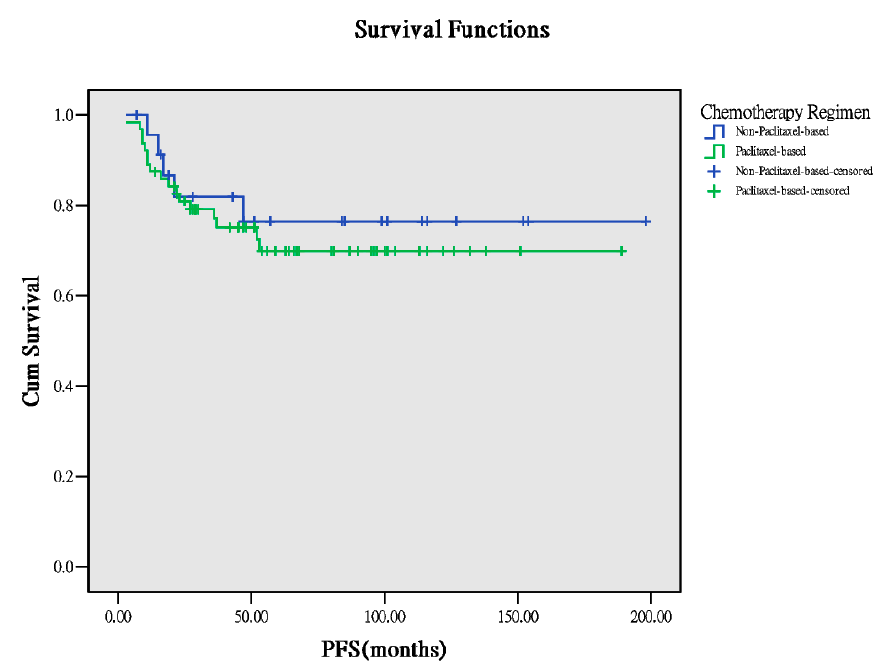
Figure 1. PFS between the di ff erent chemotherapeutic regimens ( p = 0.597).